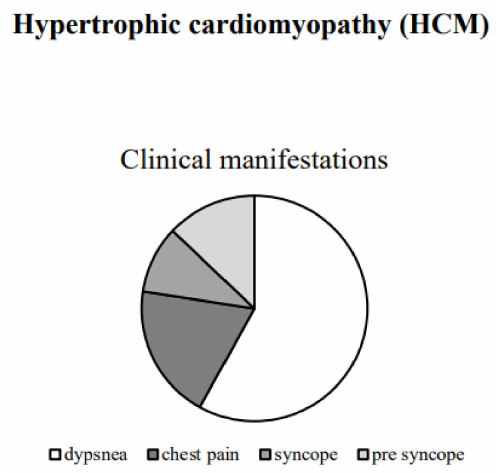
Figure 2. In this figure, we report the clinical manifestation in HCM